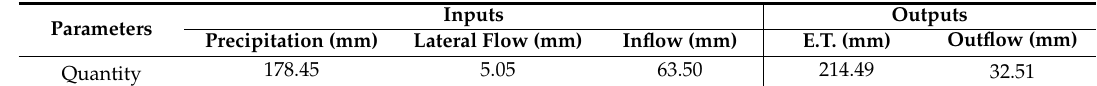
Table 8. Water balance of the entire middle reach.